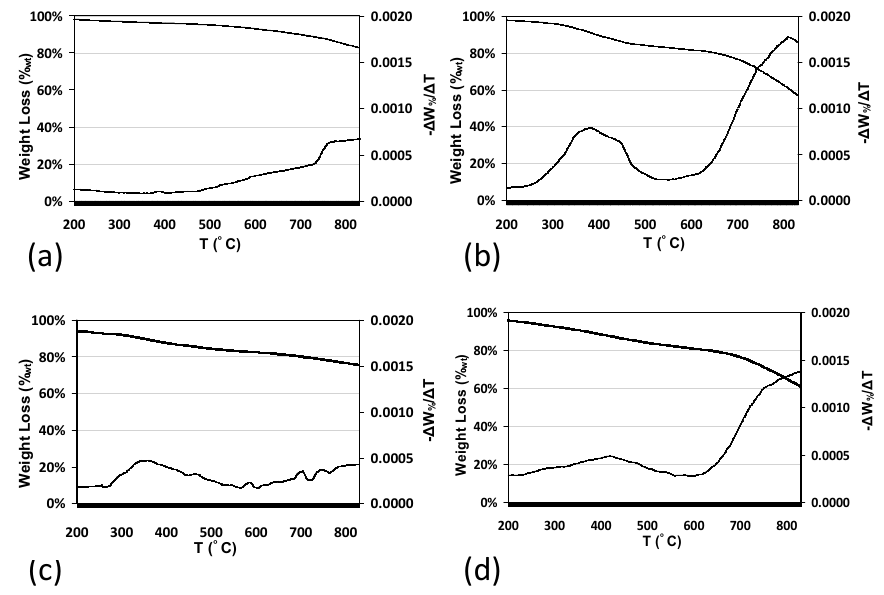
Figure 7. TGA thermograms of MW ‐ CNTs under N 2 before ( a ) and after PFPE ‐ functionalization with branched ( b ) and linear ( c ) peroxides and after fluorination with F 2 ( d ).